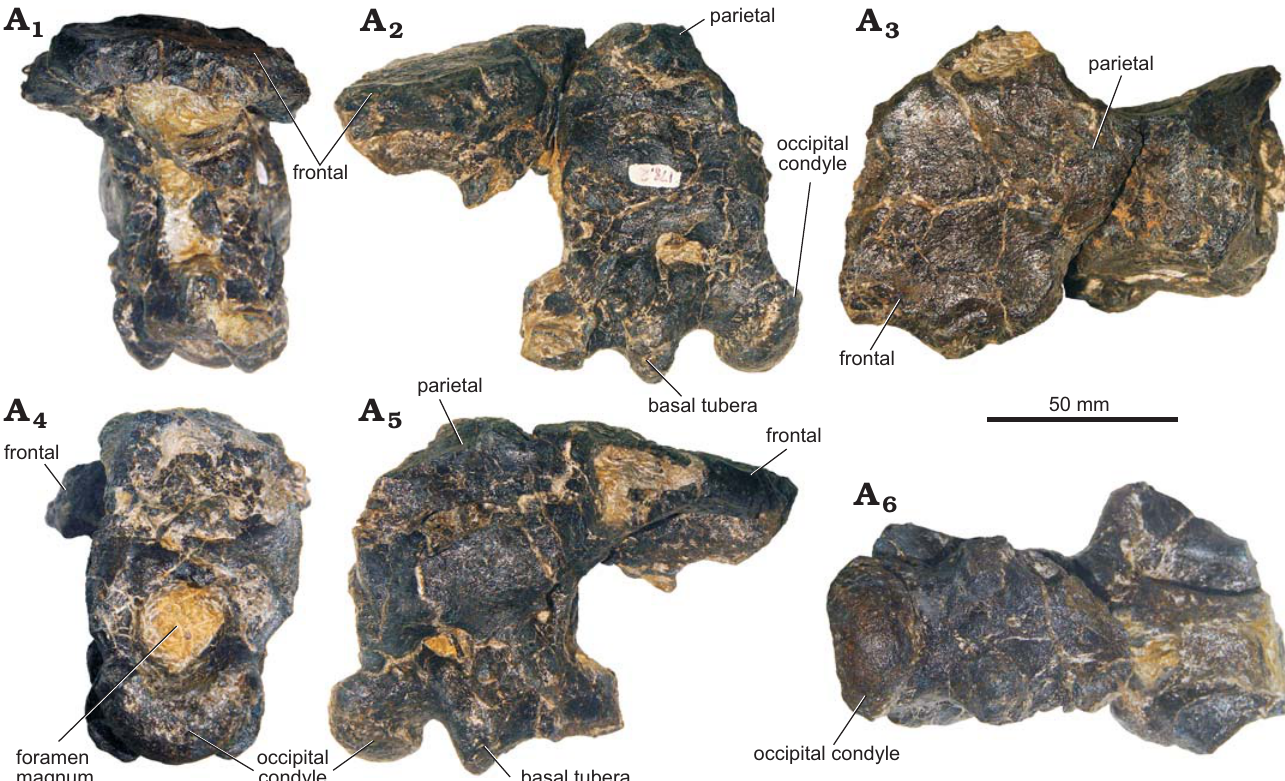
Fig. 11. Braincase of stegosaur GPDM 178, near Giffen, Cascade County, Montana; in anterior (A 1 ), left (A 2 ) and right (A 5 ) lateral, dorsal (A 3 ), posterior (A 4 ), and ventral (A 6 )